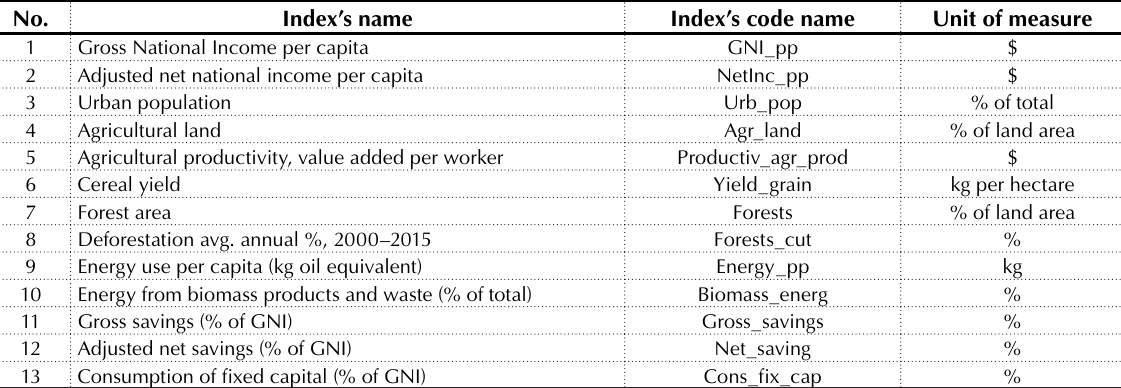
Table 1. Code names of input